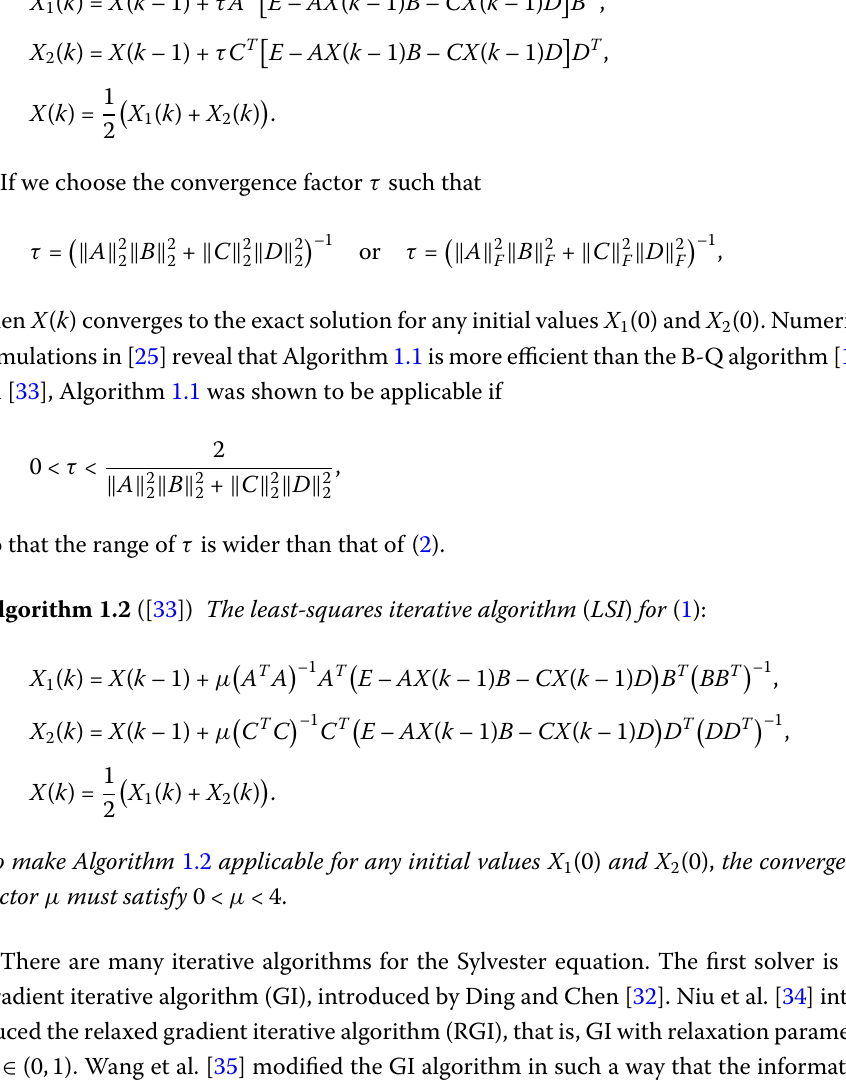
Algorithm 1.1 ([32]) The gradient iterative algorithm ( GI ) for (1):